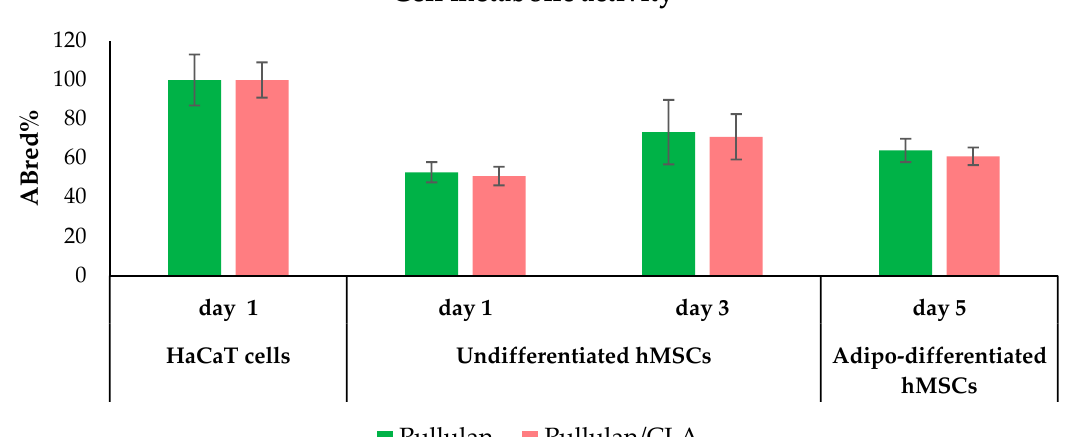
Figure 8. Bar graph showing ABred%, which indicates metabolic activity of cells after being added during the culture with a piece of soluble beauty mask, either plain or CLA-impregnated pullulan fiber meshes. No statistically significant differences were observed between pullulan and pullulan/CLA in the same cell/timepoint groups ( p = n.s.) [CLA stands for CN-NL-GA].